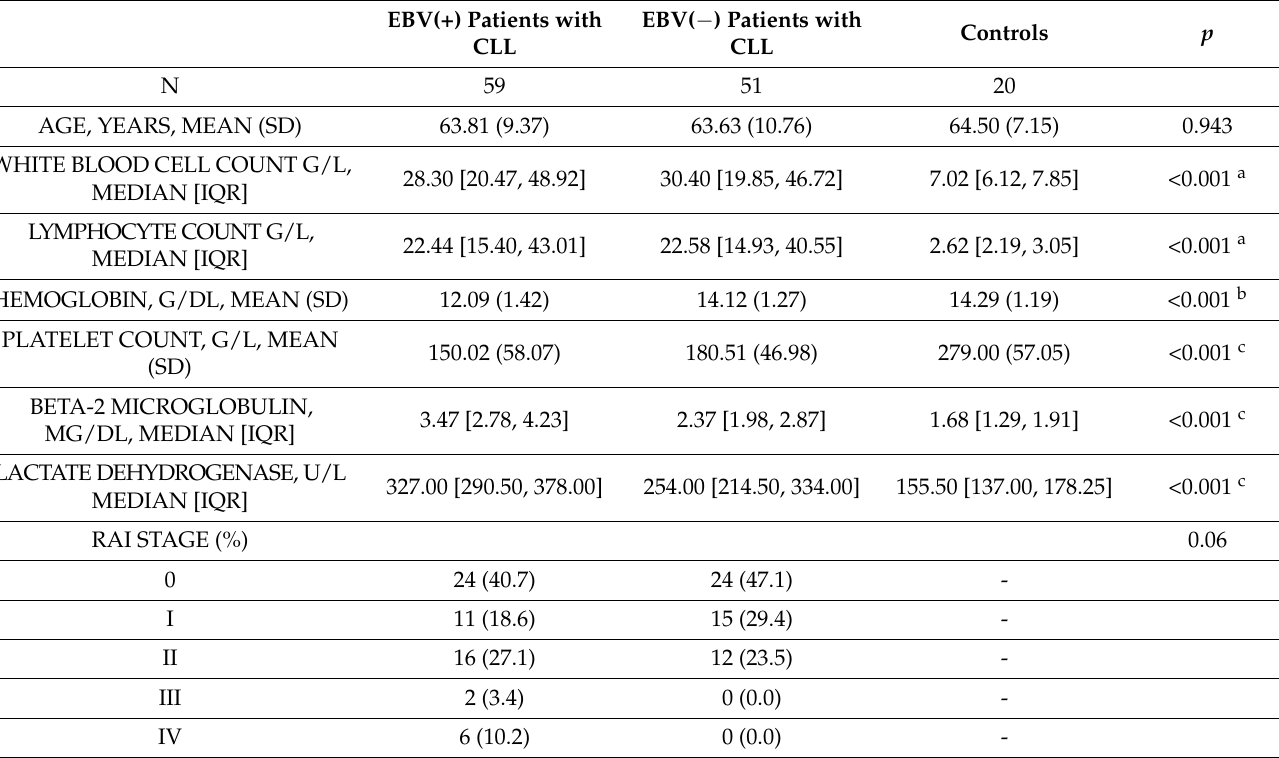
Table 1. Baseline characteristics of patients with CLL and control